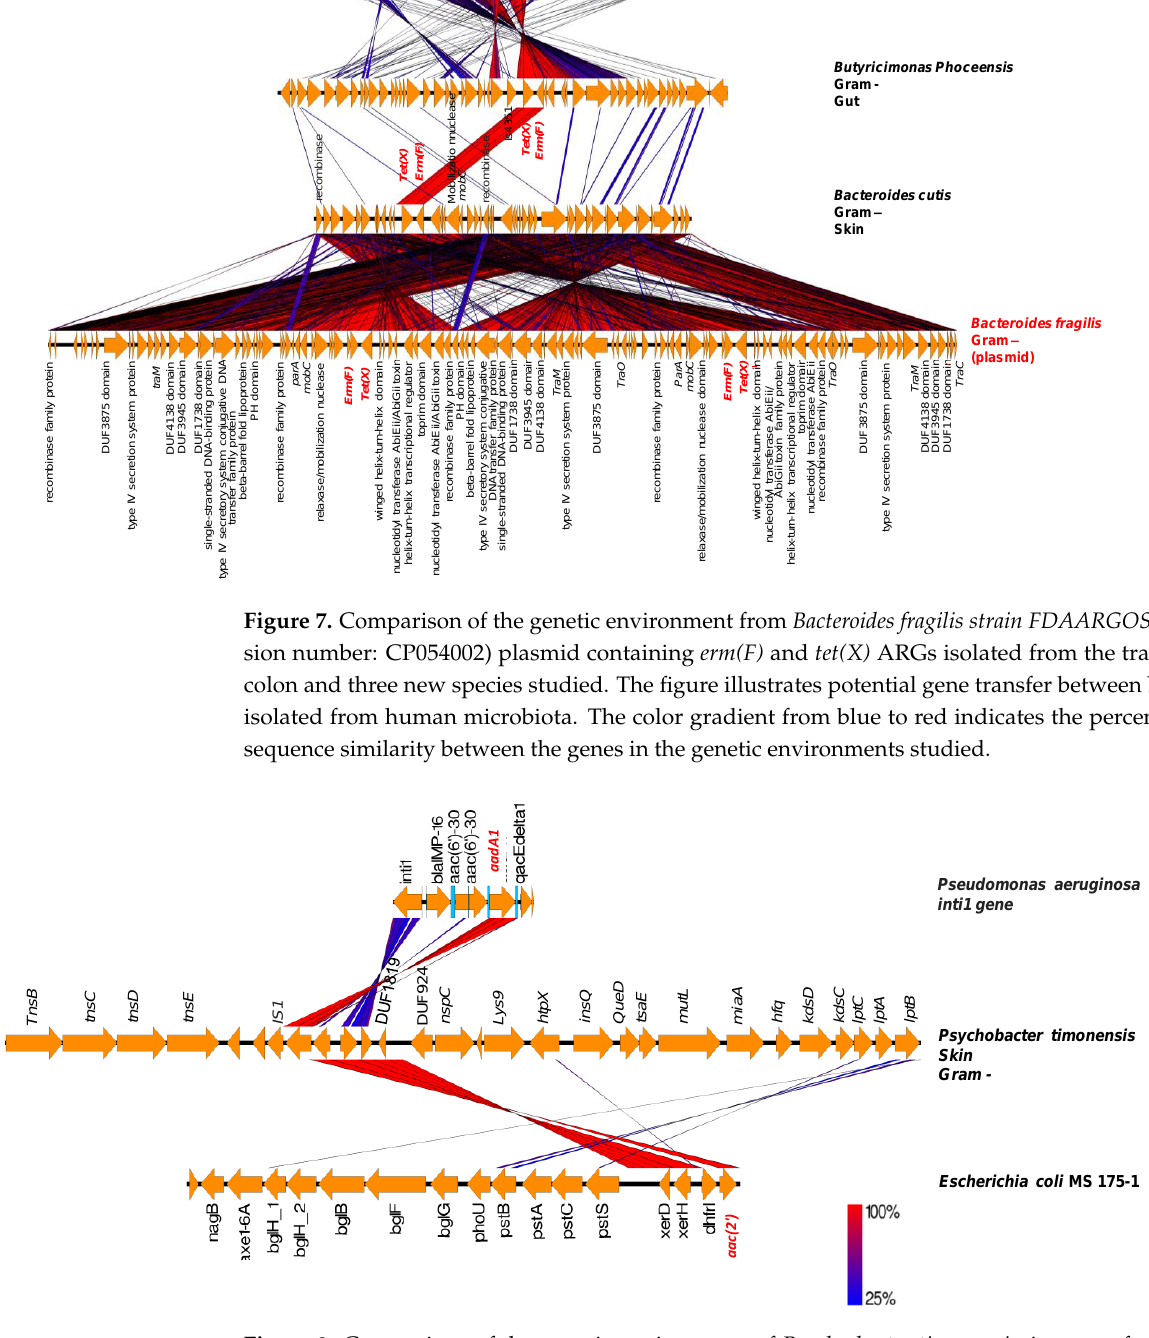
Figure 8. Comparison of the genetic environment of Psychrobacter timonensis , integron from Pseudomonas aeruginosa (Accession number: AJ584652) containing aadA1 ARG and Escherichia coli MS 175-1 with aac(2′) ARG (Accession number: ADUB00000000). The figure illustrates potential gene transfer between bacteria isolated from human microbiota. The color gradient from blue to red indicates the percentage of sequence similarity between the genes in the genetic environments studied.